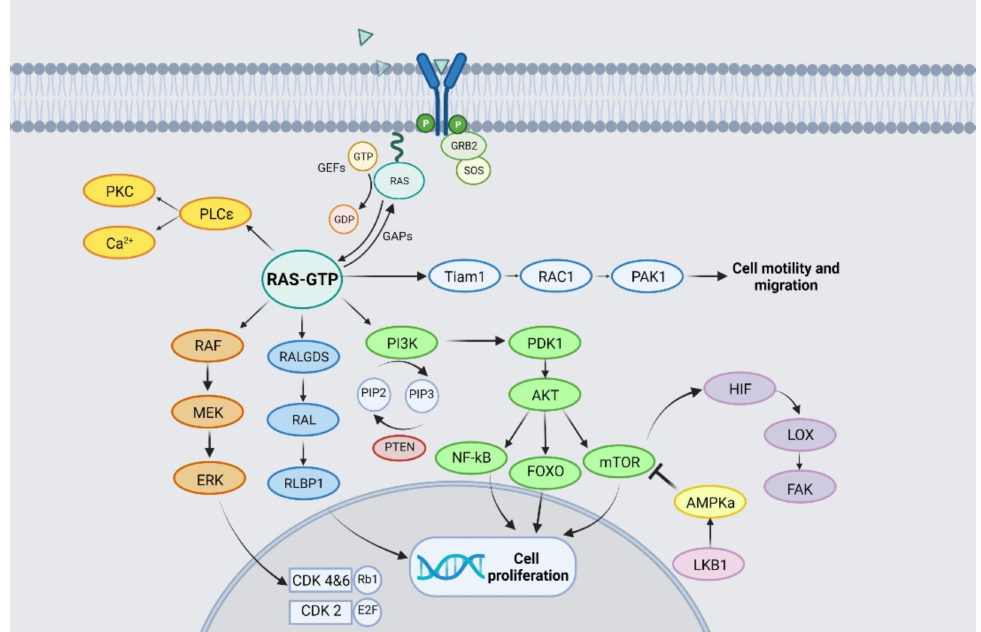
Figure 1. RAS pathway and